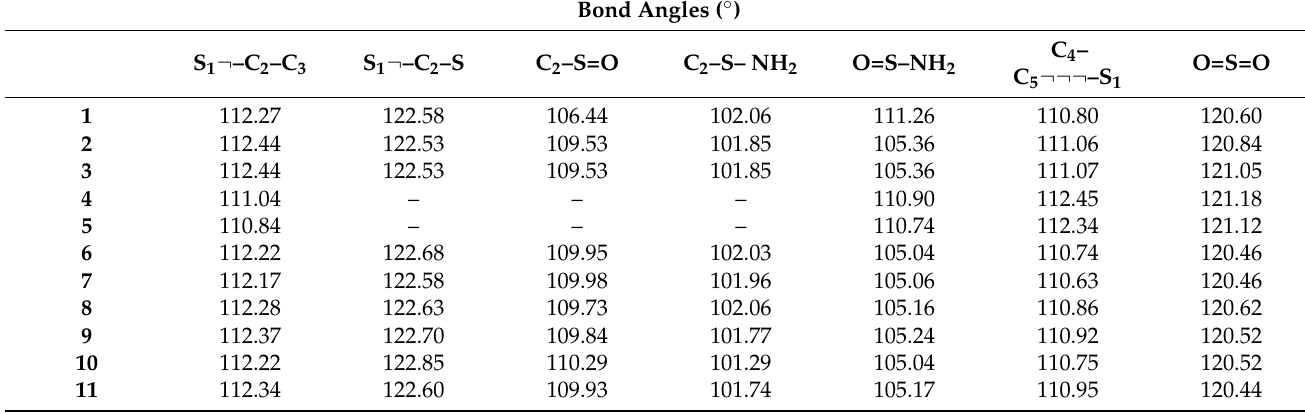
Table 2. Bond angles ( ◦ ) of selected bonds of 1 to 11